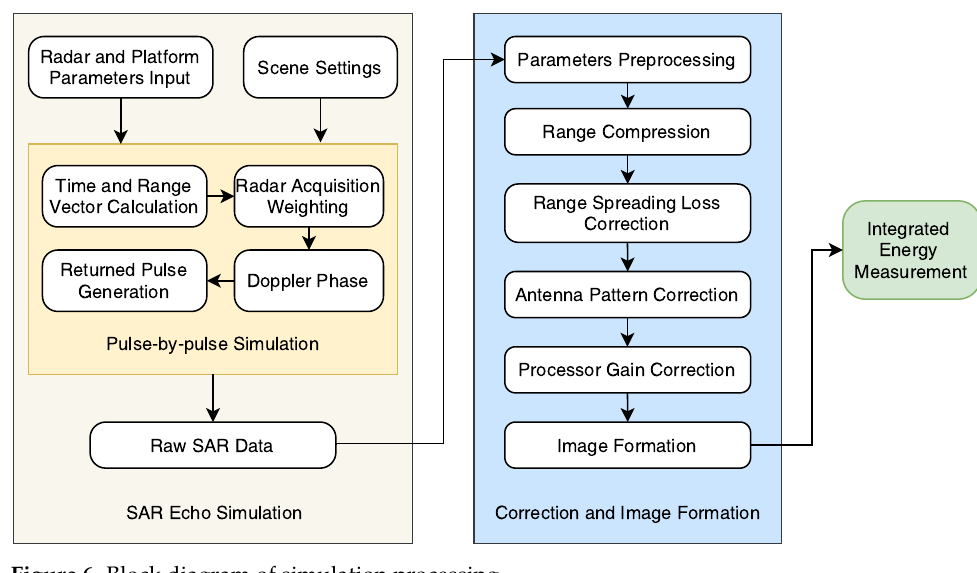
Figure 6. Block diagram of simulation processing.